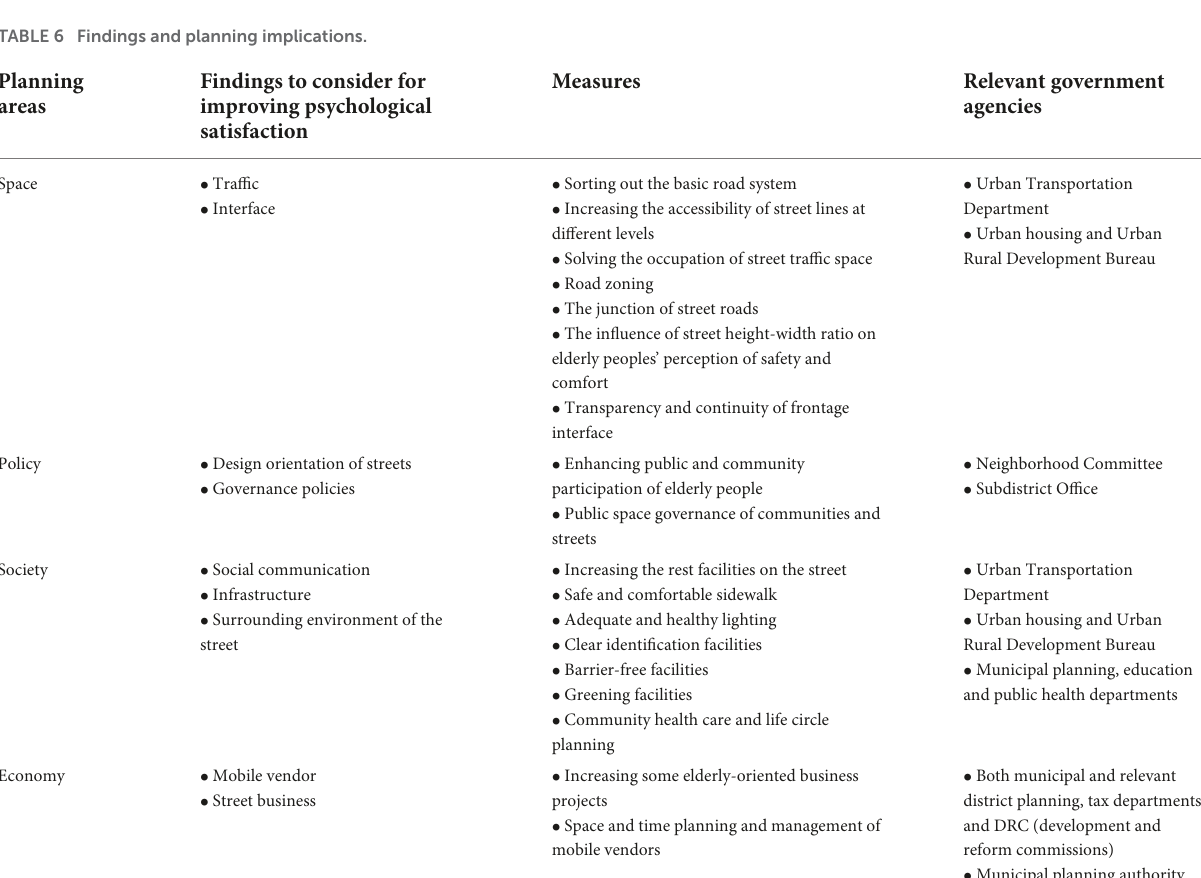
FIGURE7 Street view of Century Avenue (Source: Authors).